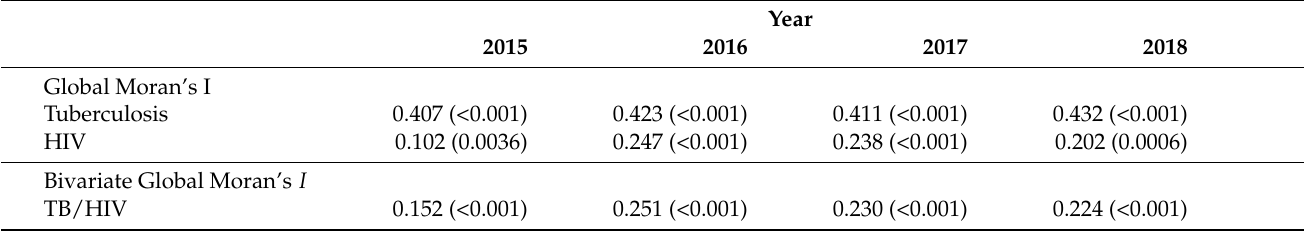
Table 1. Moran’s I statistic and correlation ( p -value) for HIV and TB cases by